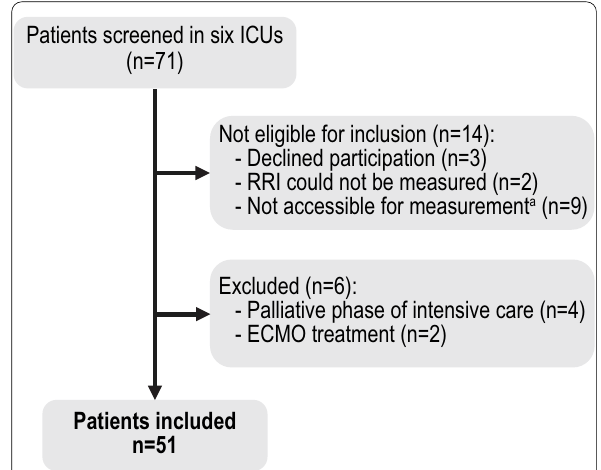
Fig. 1 Selection of the study population. ICU, intensive care unit; ECMO, extracorporeal membrane oxygenation. a Not accessible due to ongoing resuscitation, delirium/agitation, ongoing long period of mobilization/physiotherapy or unknown